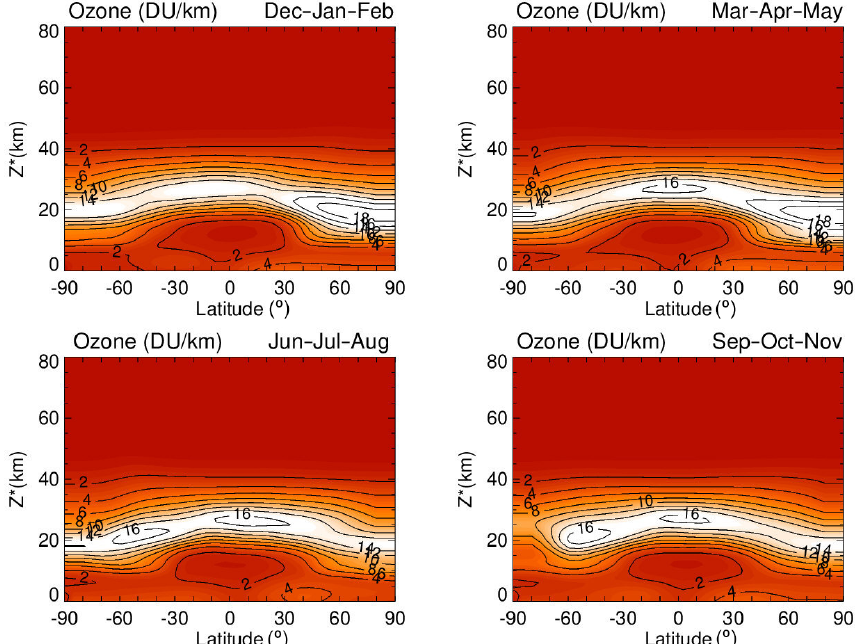
Figure 3. Meridional cross sections of derived zonal-mean vertical ozone concentration (units DUkm − 1 ) for the MLS/GMI seasonal clima- tology. This 12-month climatology is averaged over 3-month seasons (indicated) for 2004–2016 and is binned for 5 ◦ latitude bands and Z ∗ levels from 0 to 80km at 1km spacing (see text).